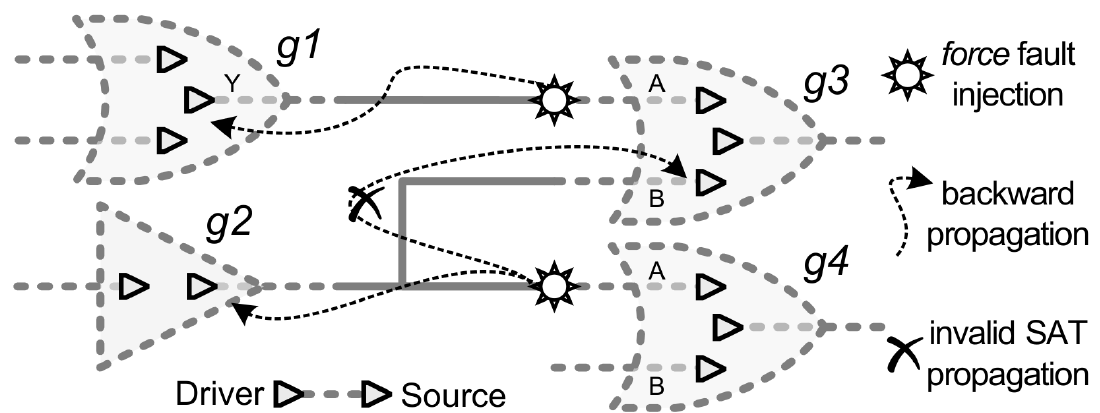
Figure 5. Highlight the importance of the M-AC/DC fault